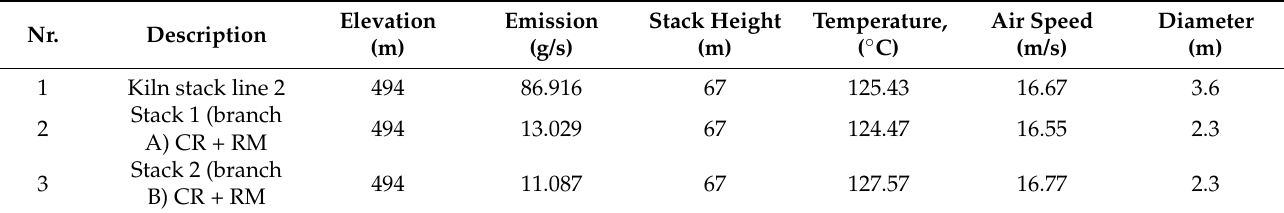
Table 8. Breeze AERMOD—CO software input data.